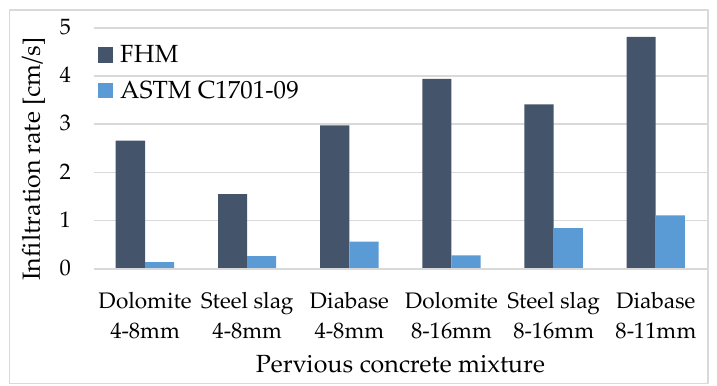
Figure 6. Results of infiltration rate for single-sized mixtures.